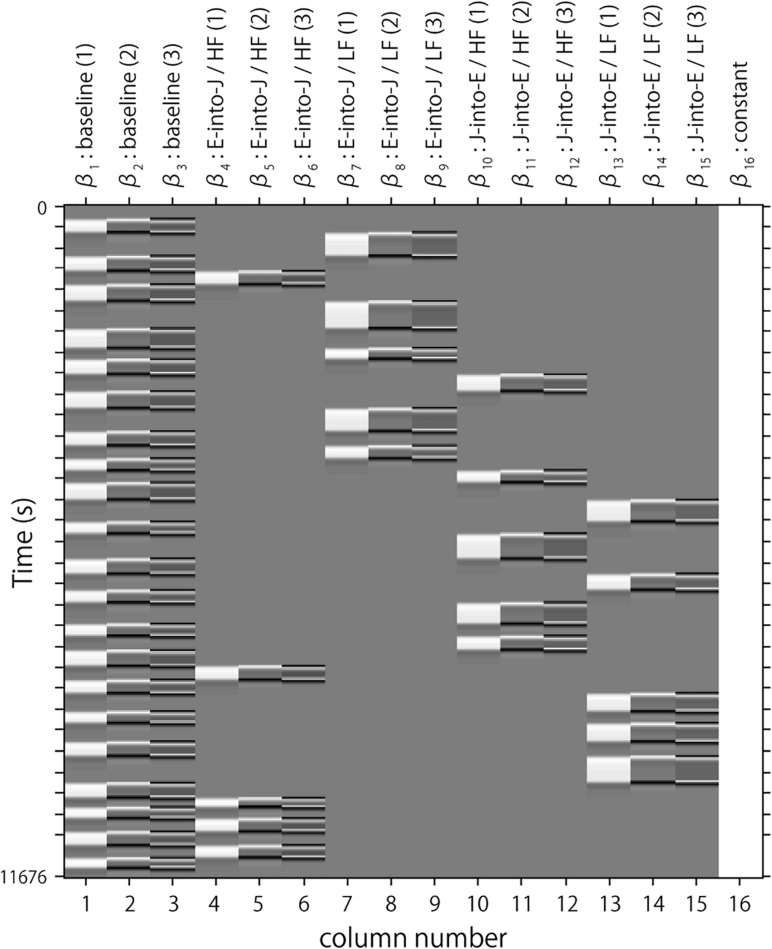
An example of a design matrix, X. The row indicates time from up to bottom. The first to third columns indicate the canonical HRF (hemodynamic response function), and the first and second derivatives, respectively, for baseline trials. The fourth to sixth columns indicate the canonical HRF, and the first and second derivatives, respectively, for task trials (English into Japanese/high familiarity). The seventh to ninth columns indicate the canonical HRF, and the first and second derivatives, respectively, for task trials (English into Japanese/low familiarity). The 10th to 12th columns indicate the canonical HRF, and the first and second derivatives, respectively, for task trials (Japanese into English/high familiarity). The 13th to 15th columns indicate the canonical HRF, and the first and second derivatives, respectively, for task trials (Japanese into English/low familiarity). The 16th column indicates the constant.